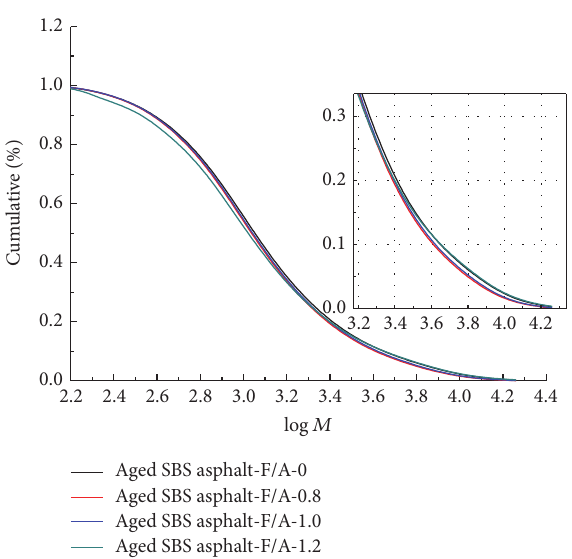
Figure 7: The molecular weight content of the bitumen phase in the modified asphalt mortar.